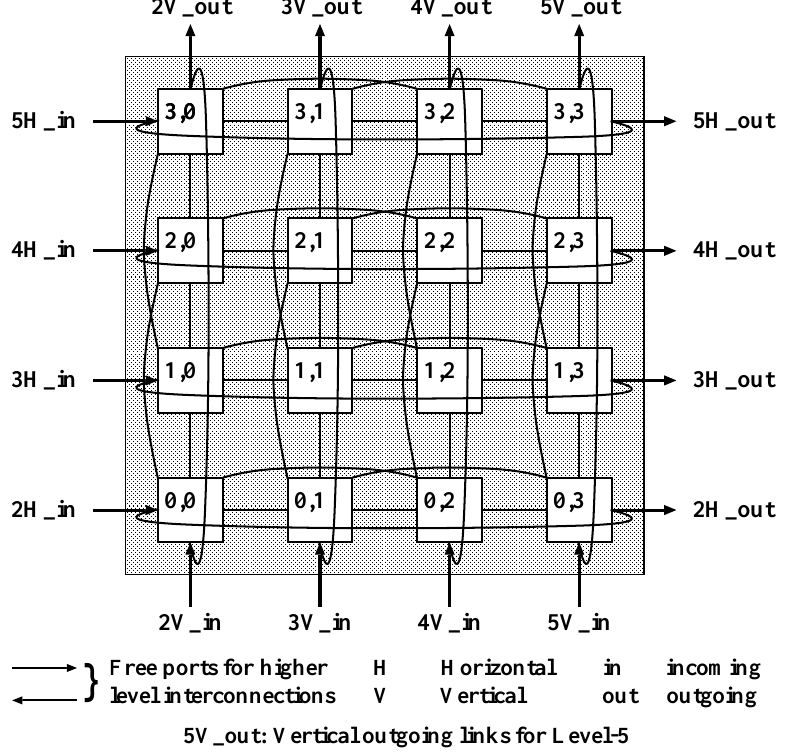
Figure 1. A 4 × 4 basic module of a